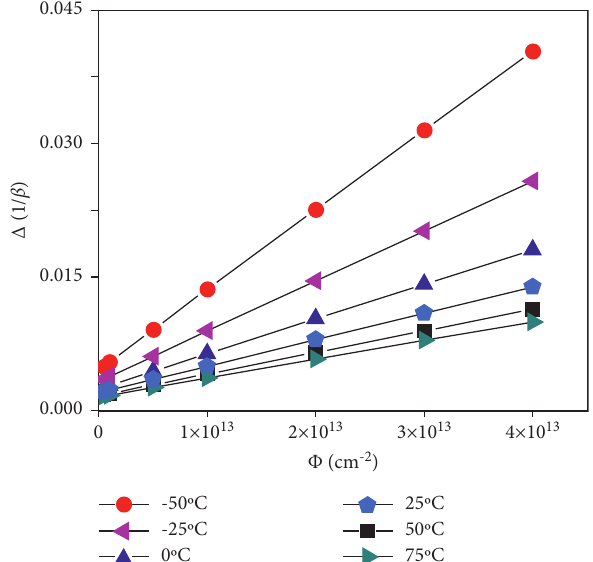
Figure 9: The influence of TID effects on the carrier recombination rate of DD effects.